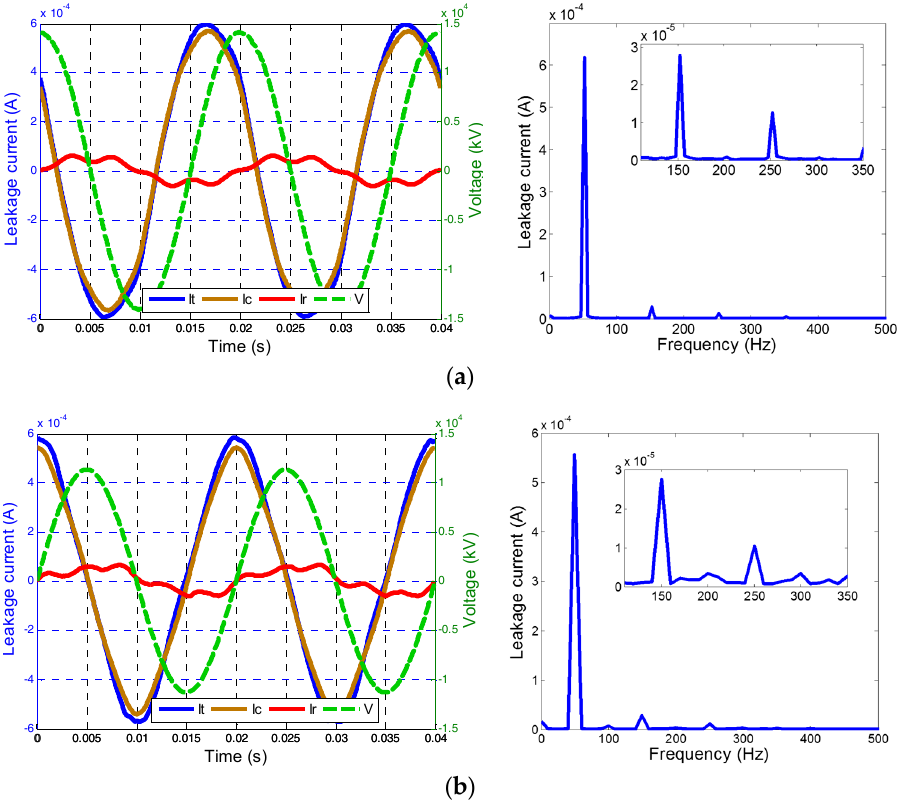
Figure 8. Leakage current waveforms and harmonic components at 10 kV rms applied voltage from the ( a ) measurement; ( b ) FEA model.